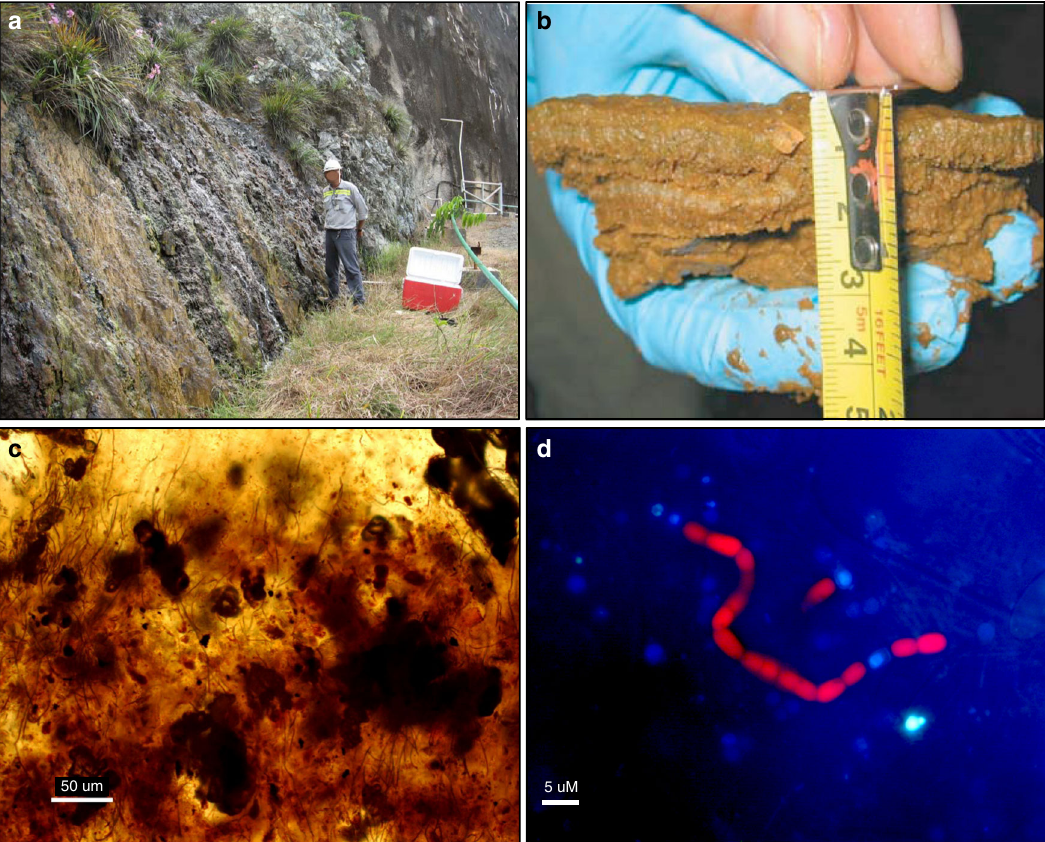
Fig. 1 Images of the Balambano mat. a Field site with microbial mat growing on the outcrop of ultramaphic rock. b Cross section of a freshly sampled microbial mat showing the horizontal layering of the mat and a green, photosynthetic layer close to the mat surface. The orange colour is likely due to the presence of iron(oxy)hydroxides. c Thin section of the microbial mat showing trapped opaque minerals suspended in a translucent matrix containing abundant microbial fi laments. d Fluorescence microscopy image of fi lamentous cyanobacteria in the mat showing presence of heterocystous cyanobacteria, red is from chlorophyll auto fl uorescence and the heterocyst is identi fi ed by its lack of